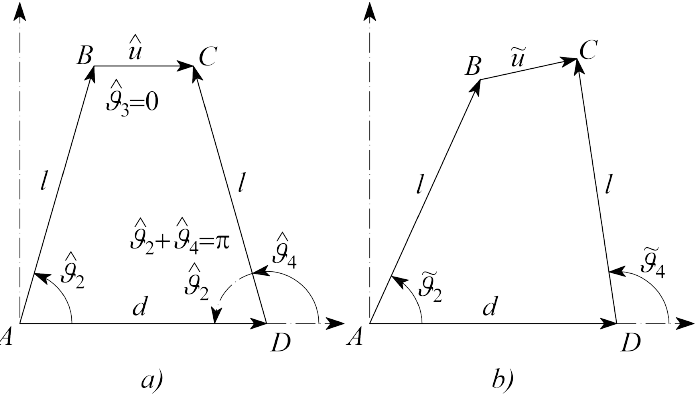
Figure 5. The micro–system closed loop chain in the initial ( a ) and in the generic ( b ) configuration.